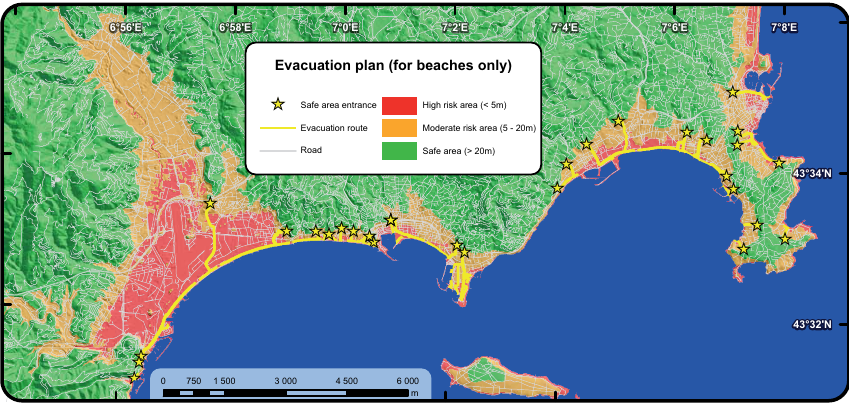
Fig. 12. Suggestion of large-scale evacuation